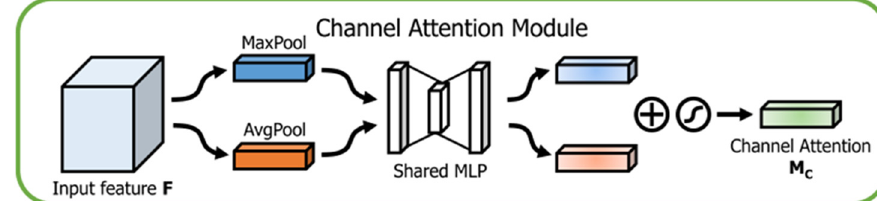
Figure 6. Channel attention structure diagram.